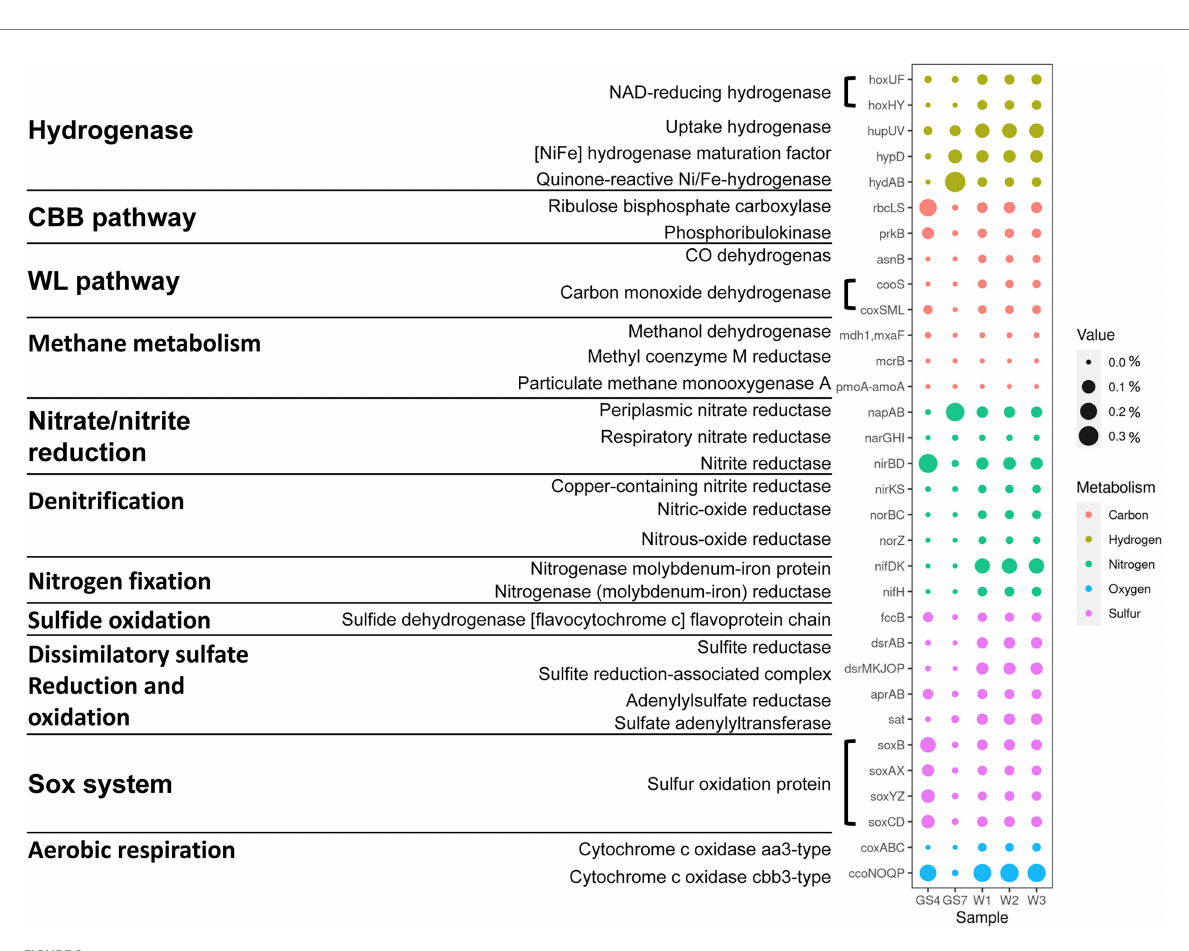
FIGURE 2 Differences in key genes involved in carbon, hydrogen, nitrogen, sulfur and oxygen metabolism among the SW-HTV sediment